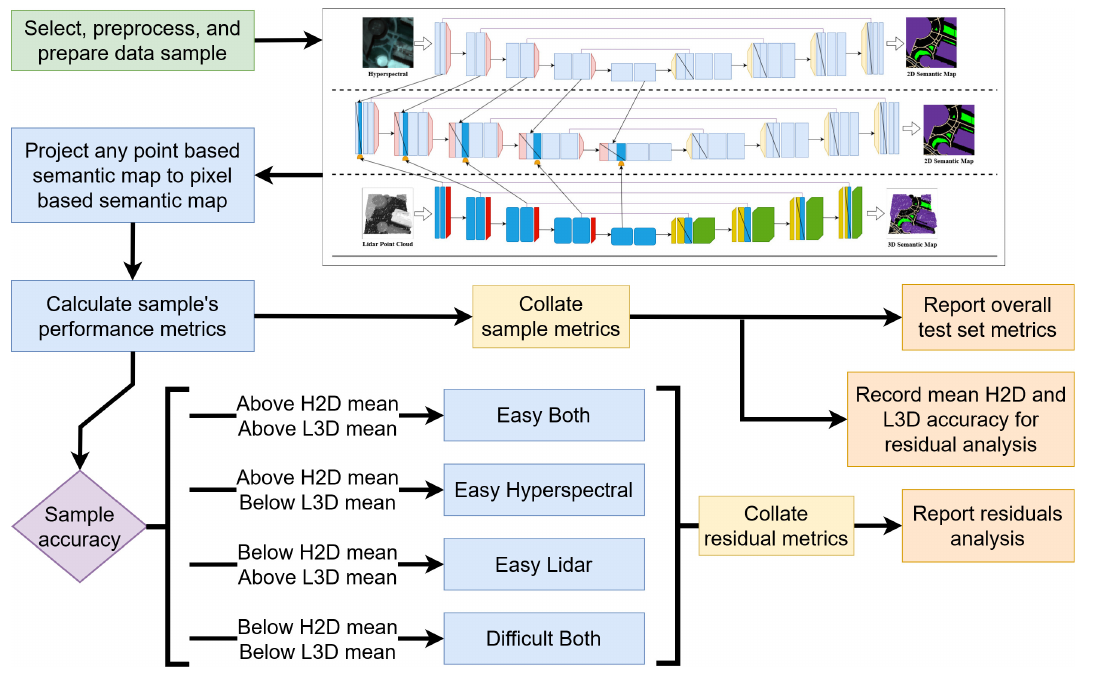
Figure 8. Overall workflow of the methodology from data to decision products. First, the GRSS18 data set [21] is modified and preprocessed to produce training, validation, and testing multimodal samples. A model from each of the five network architectures described is then trained (L2D and H2D_L2D not pictured). The predicted semantic maps are post processed; sample metrics are calculated and collated into overall test set metrics. Finally, the results of H2D and L3D are used to perform the residual analysis. Overview and motivation of residual analysis provided in Section